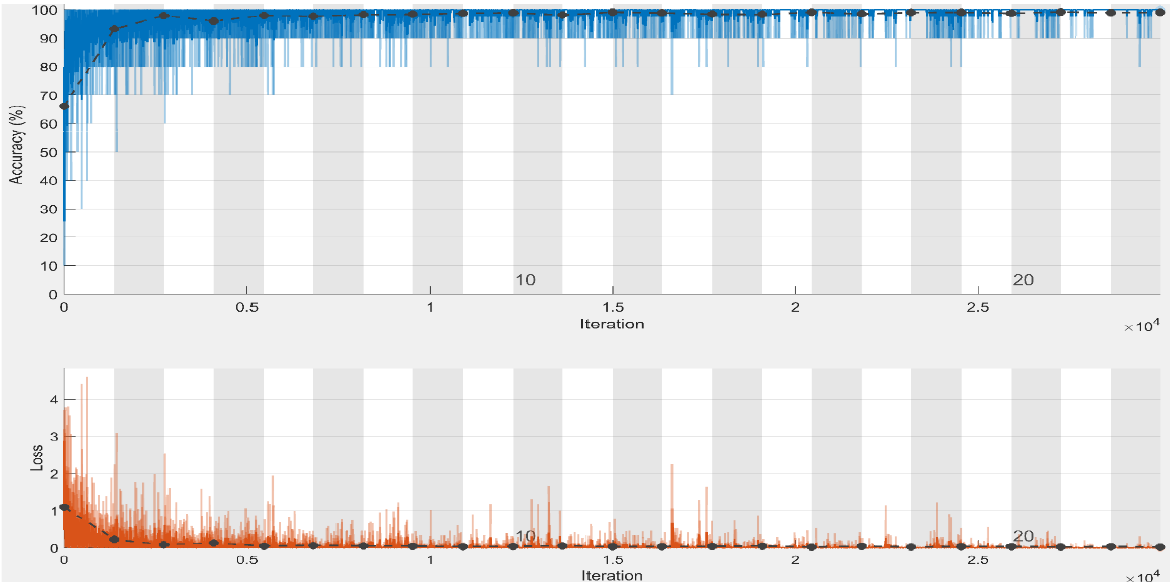
Figure 6. Training and validation accuracy and loss plots of three-class classification (black line shows the testing accuracy and loss) using chest radiographs dataset.